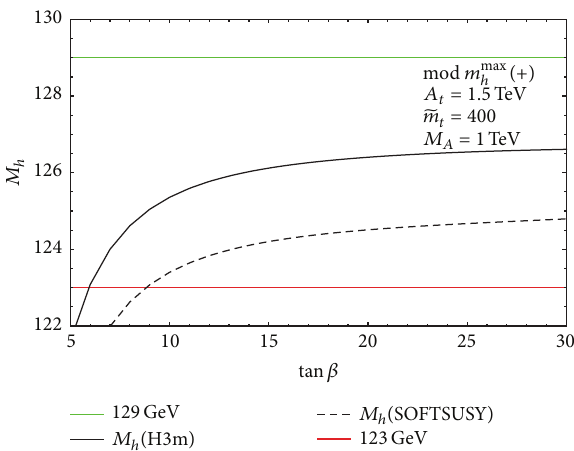
Figure17:ThelightHiggsbosonmassasafunctionoftan 𝛽 tothree- loop accuracy from